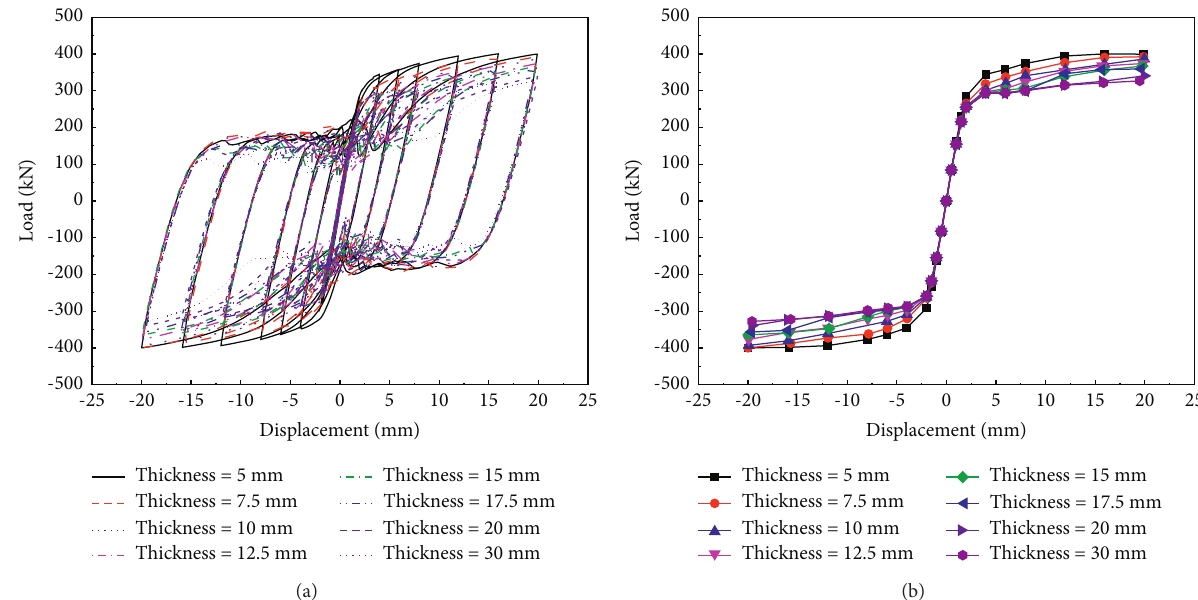
Figure 25: The effect of gap thickness. (a) Hysteretic curves. (b) Skeleton